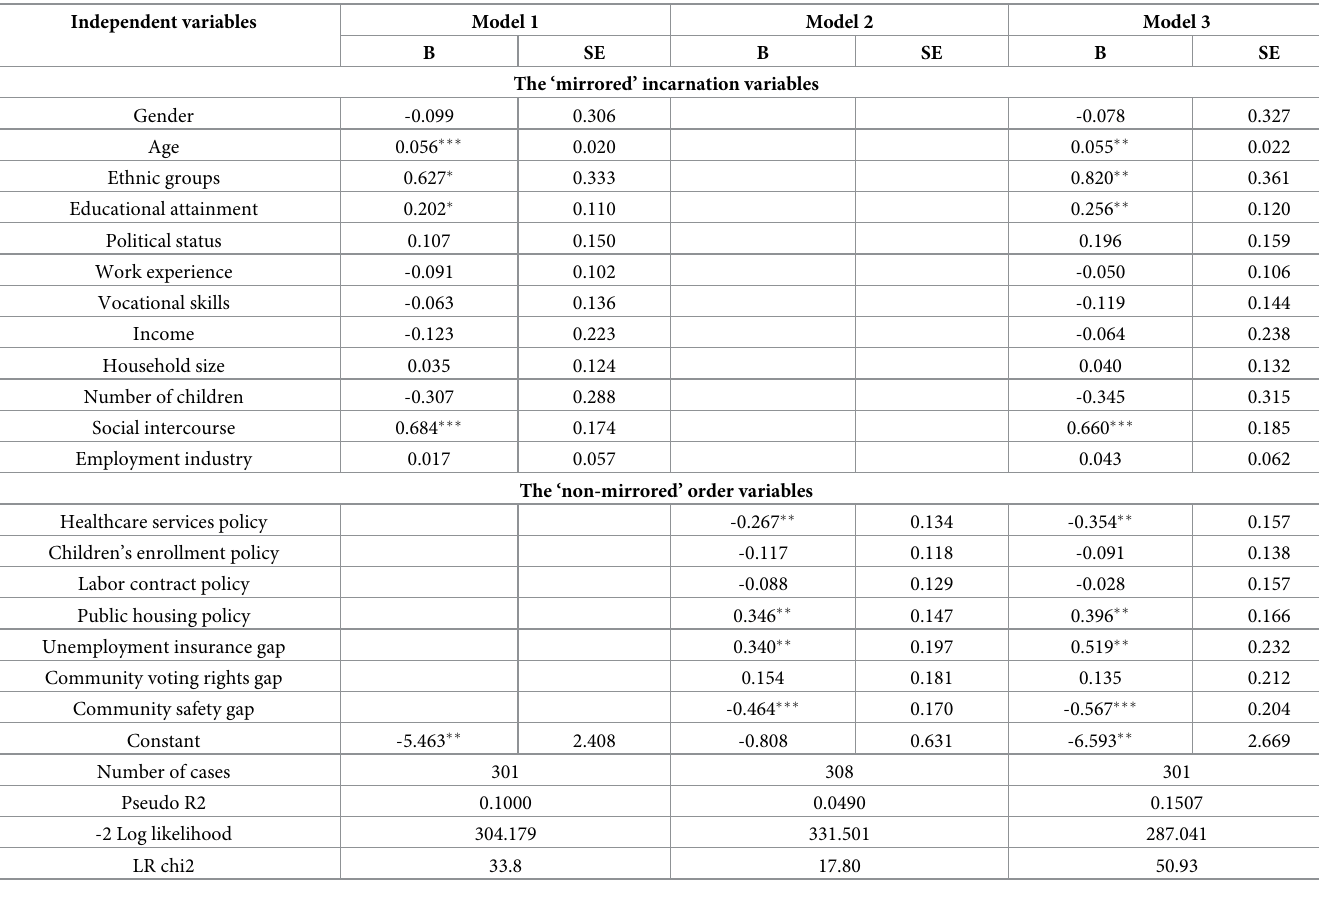
Table 3. Binary Logit regression results.